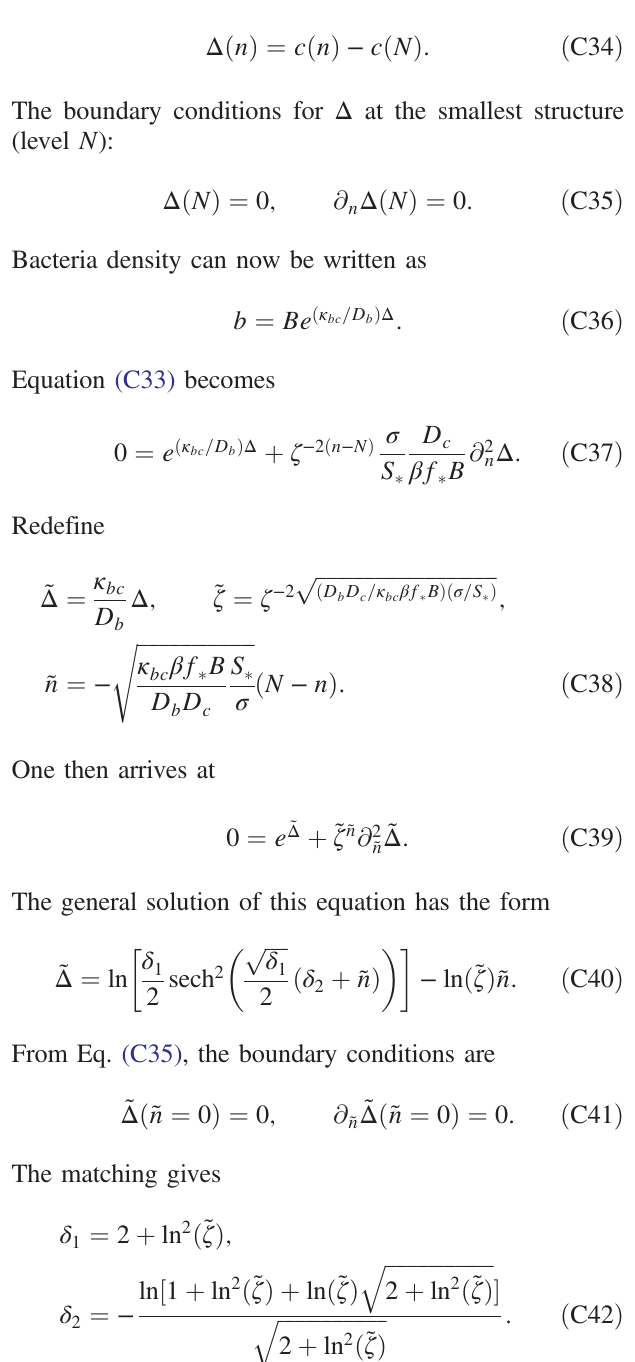
ffiffiffiffiffiffiffiffiffiffiffiffiffiffiffiffiffiffiffiffi